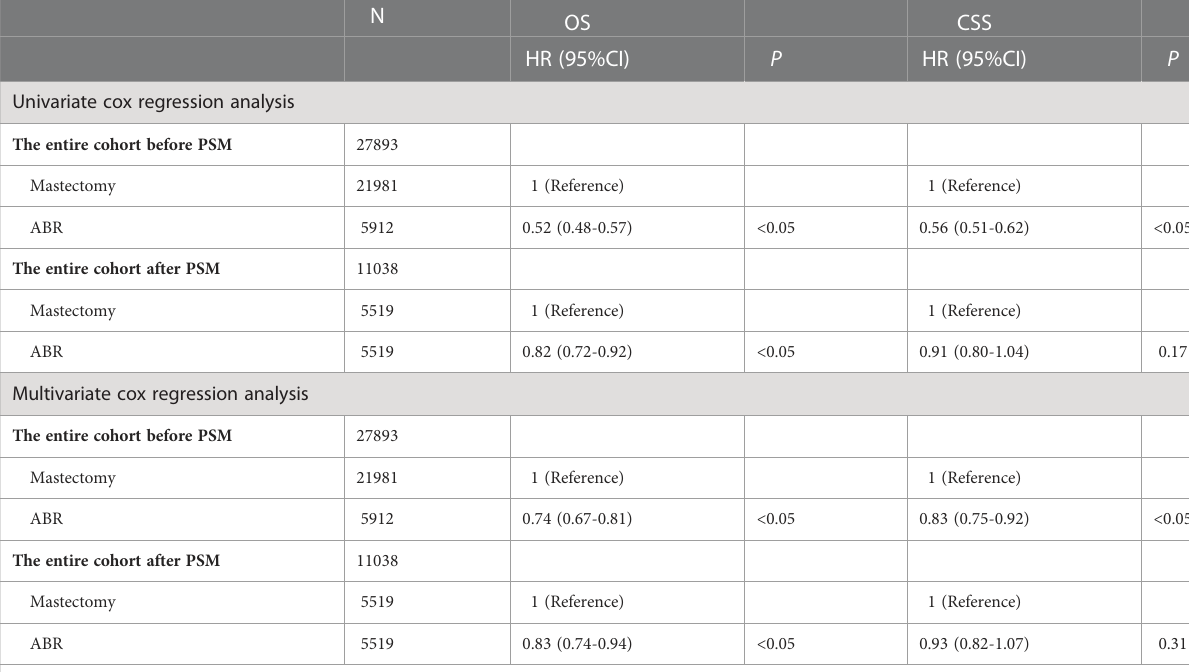
TABLE 3 Univariate and multivariate cox regression analysis of OS and CSS.